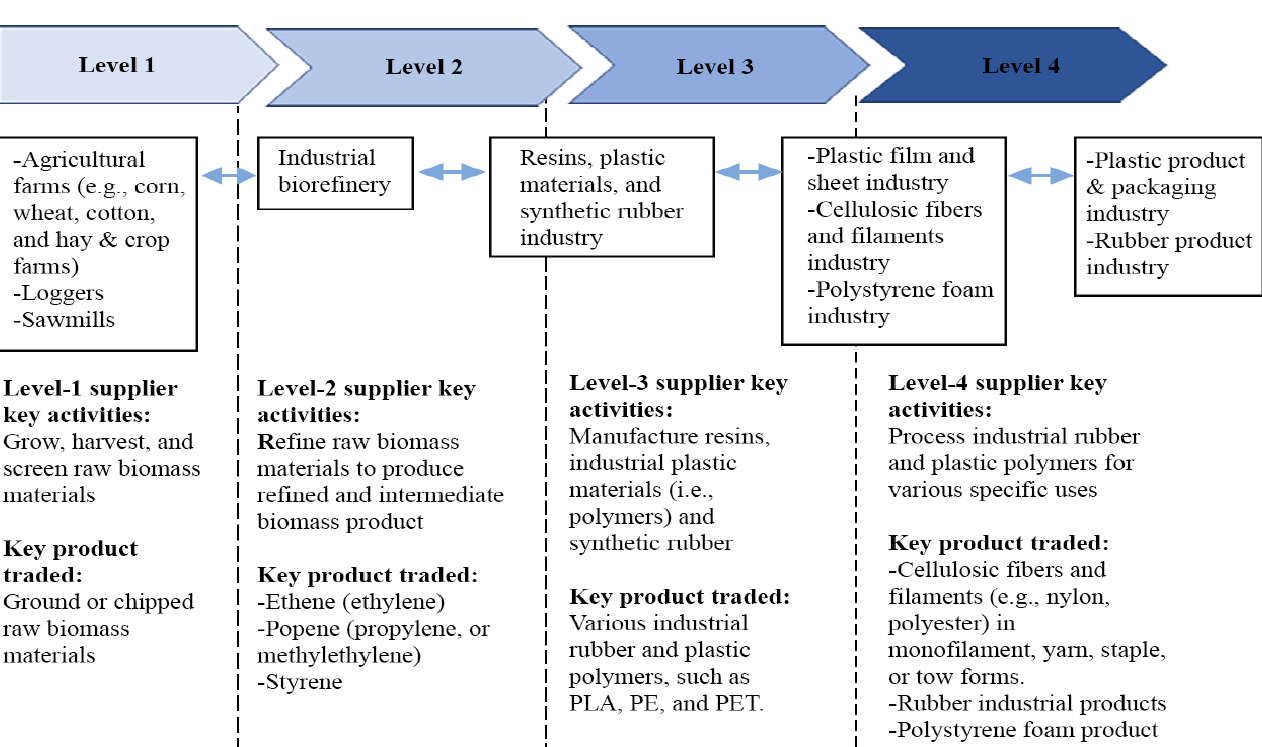
Figure 8. Simplified example of multi-level rubber and polymer markets for biomass (adapted from [207] ).